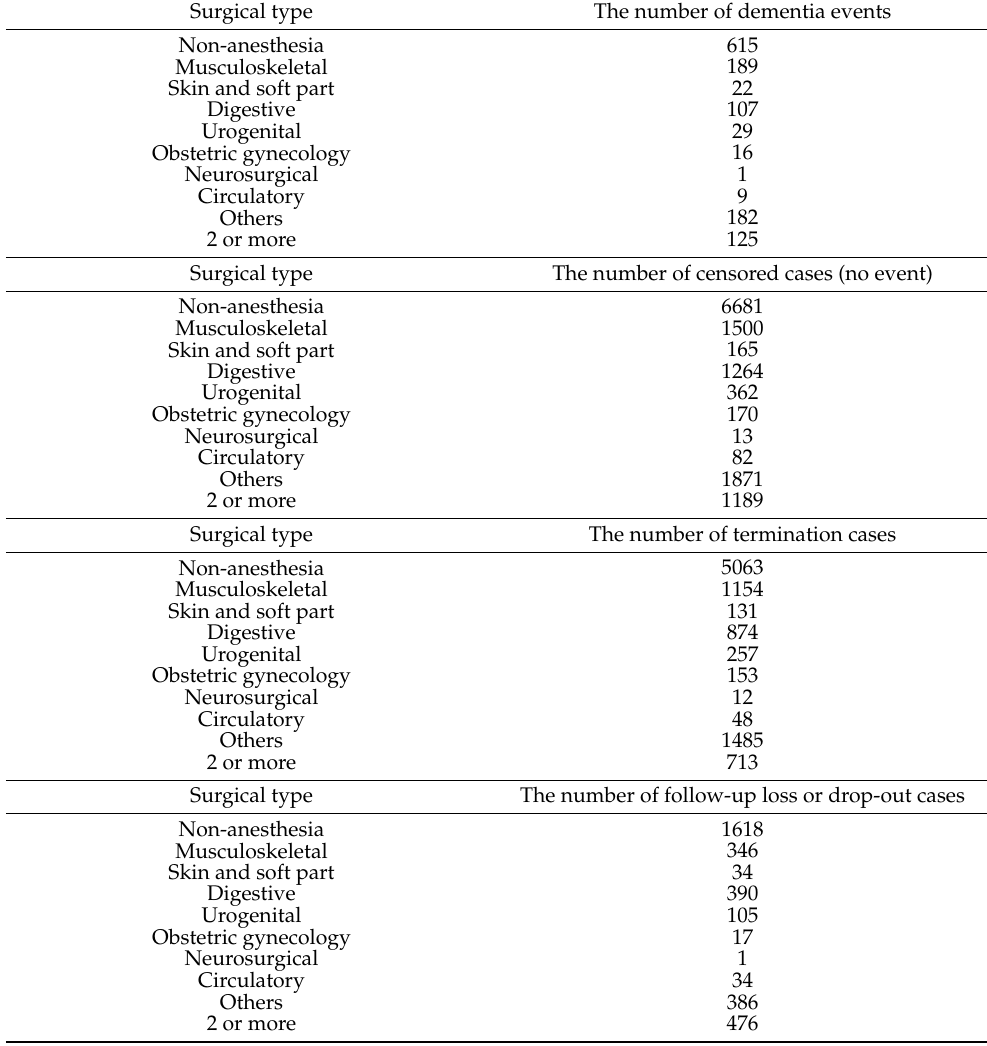
Table A3. Description of time to event and censored